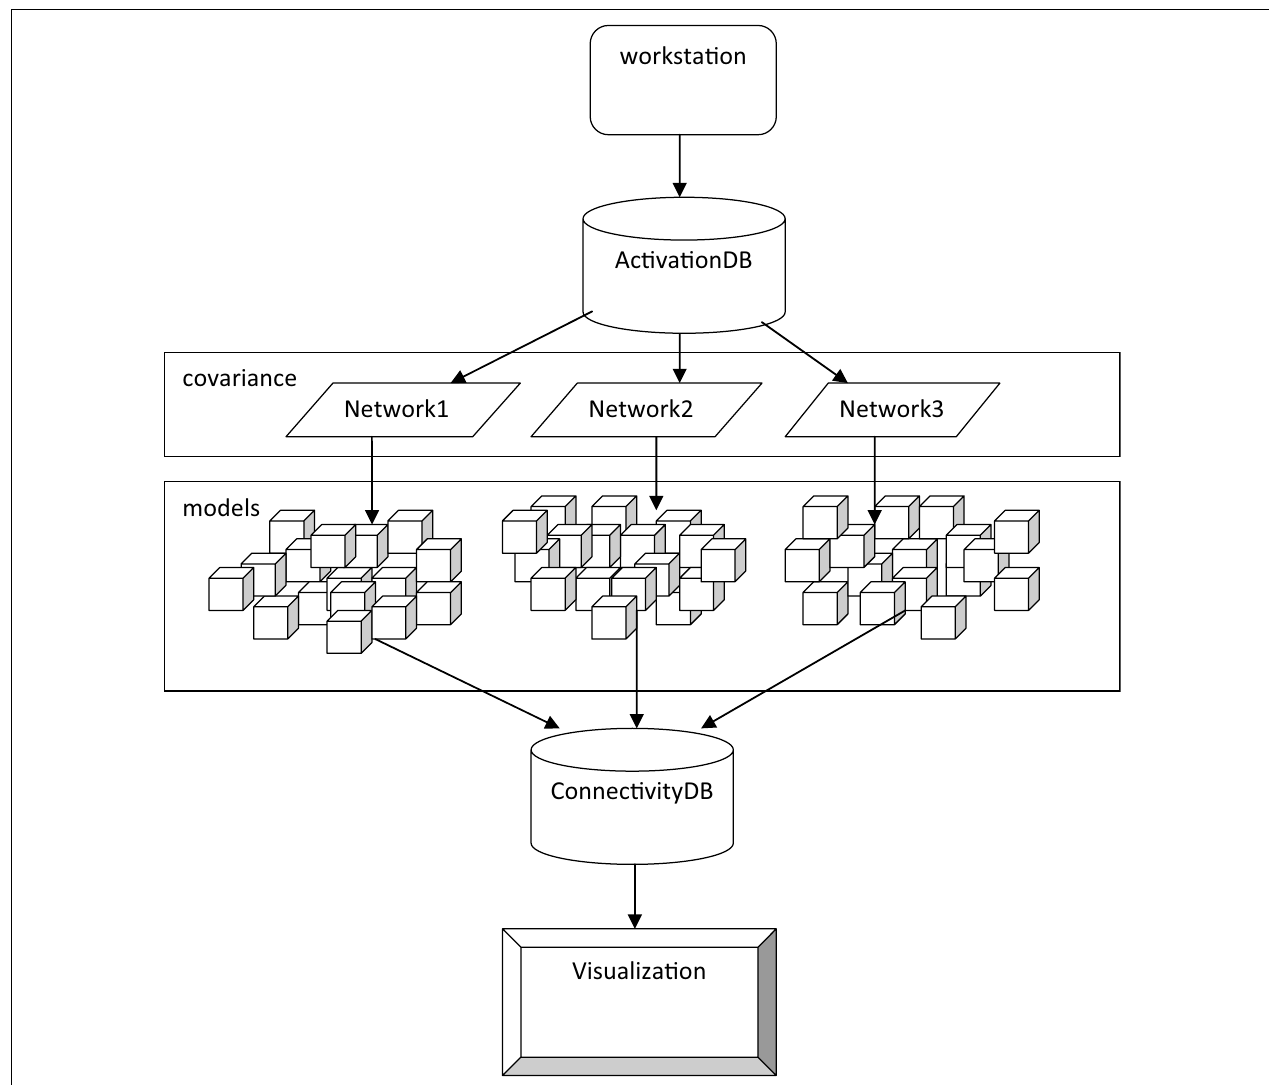
FIGURE 4 | Multinetwork Swift workfl ow for the Emblem with Speech